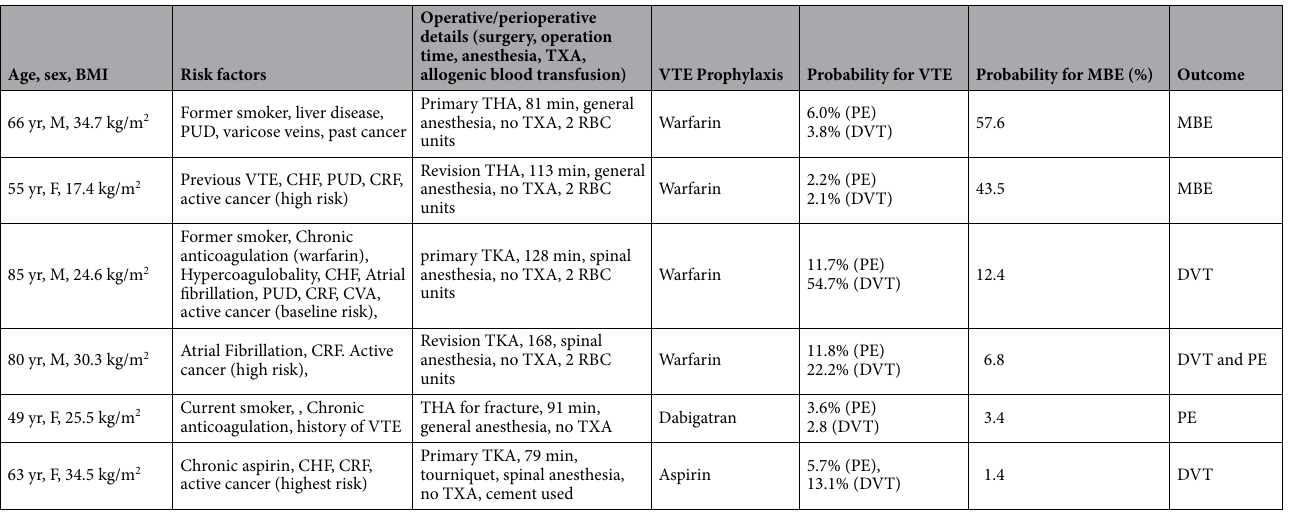
Table 2. Example patient characteristics, expected probability for failure and actual